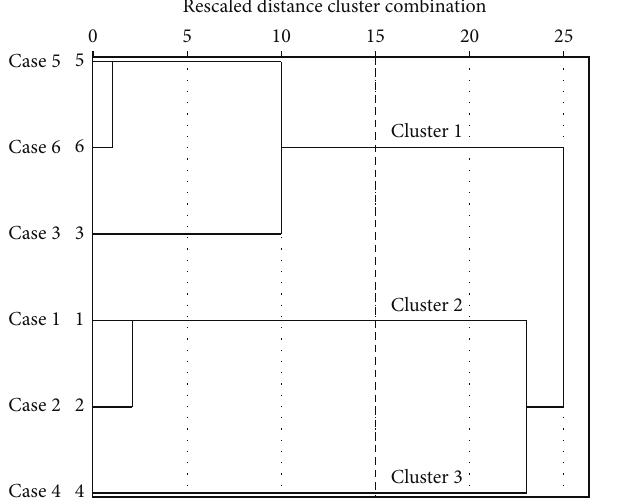
Table 3: Mean difference of in situ and ex situ water quality parameters before and after rain ( 𝑁 = 9 ).